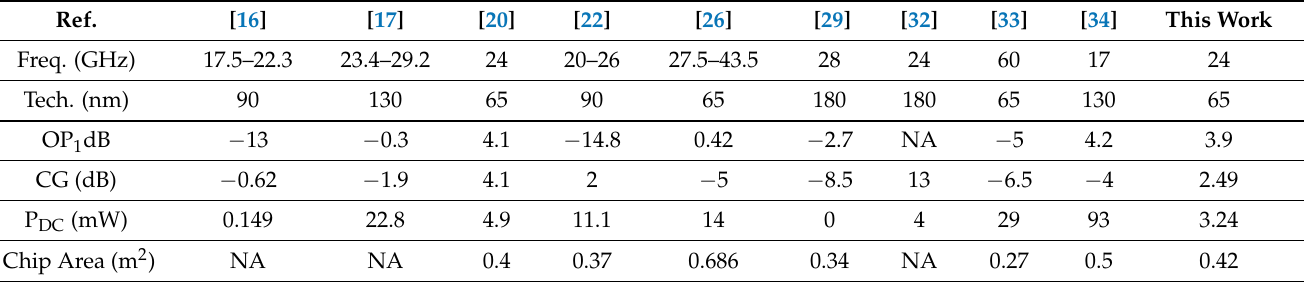
Table 3. Comparison summary for recently reported